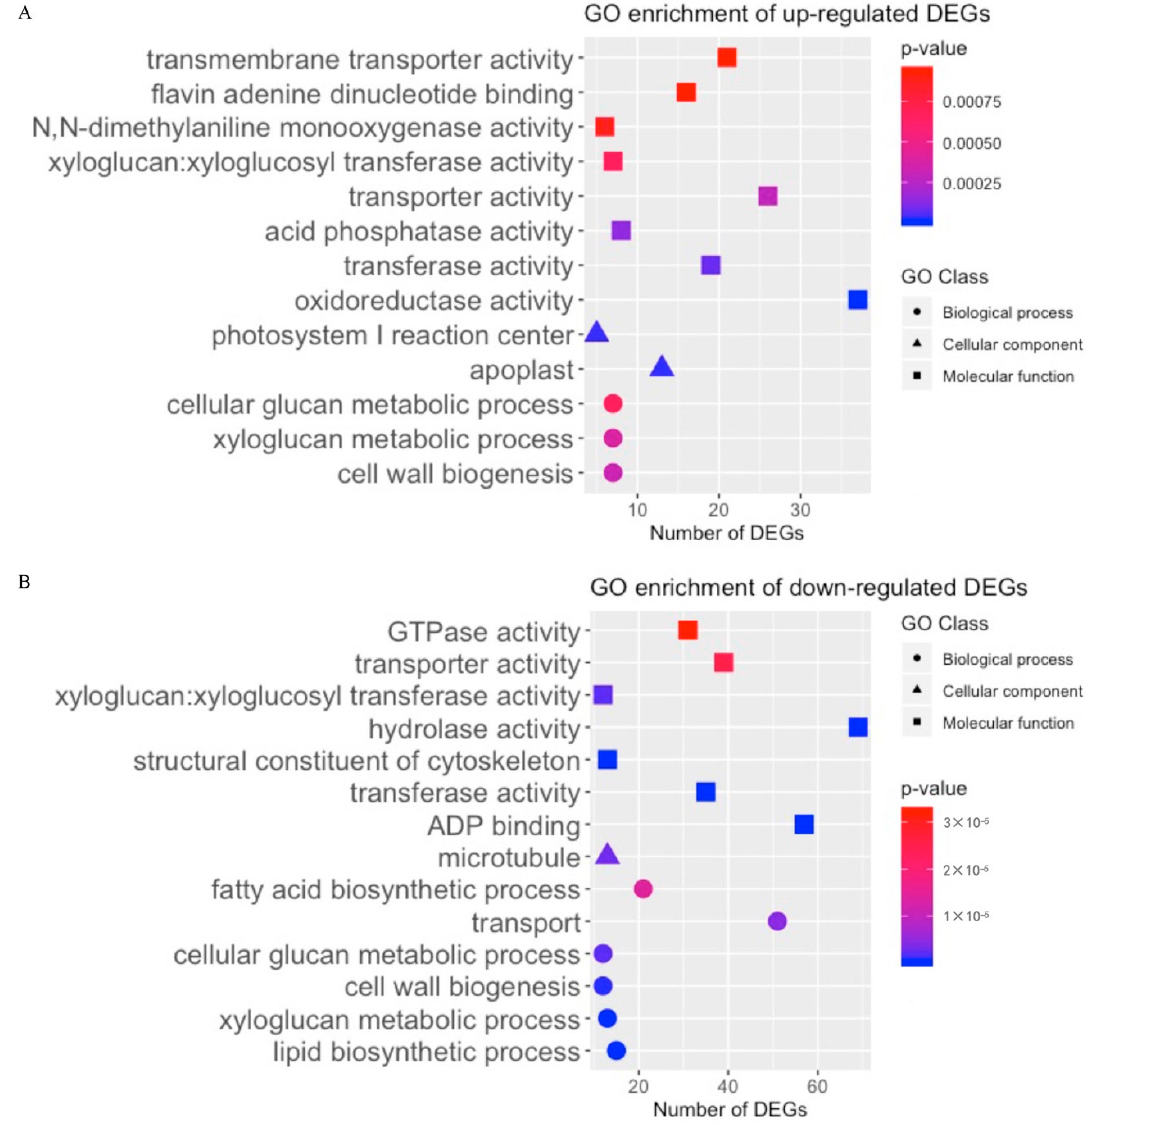
Figure 7. Gene ontology (GO) enrichment results of nonredundant DEGs in the lintless accession. ( A ) GO enrichment results of nonredundant upregulated DEGs in the LL group. ( B ) GO enrichment results of nonredundant down-regulated DEGs in the LL group.